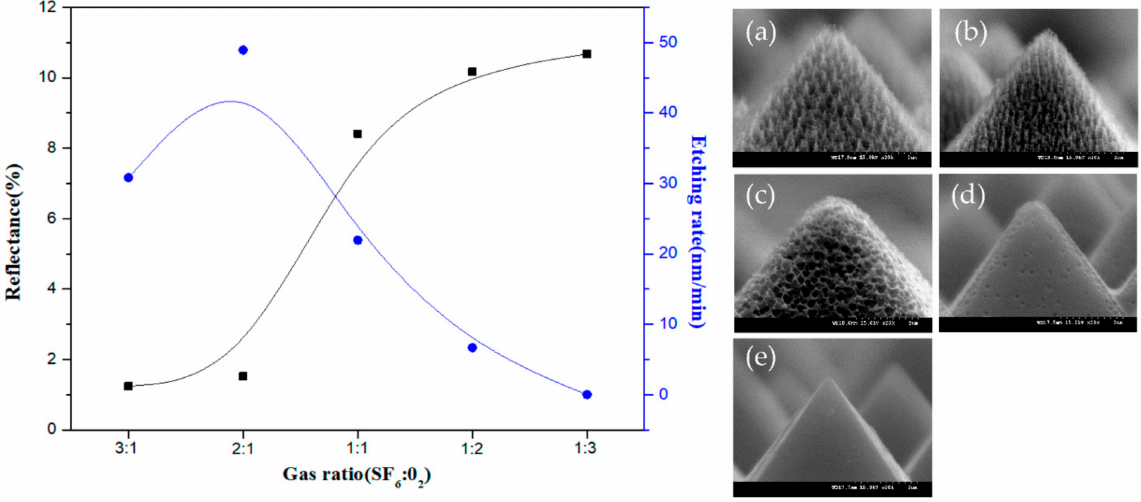
Figure 12. Reflectance and cross-section SEM images of wafer surfaces according to gas ratio for the two-step etching process with alkali solution and RIE: ( a ) SF 6 :O 2 = 3:1, ( b ) SF 6 :O 2 = 2:1, ( c ) SF 6 :O 2 = 1:1, ( d ) SF 6 :O 2 = 1:2, and ( e ) SF 6 :O 2 =